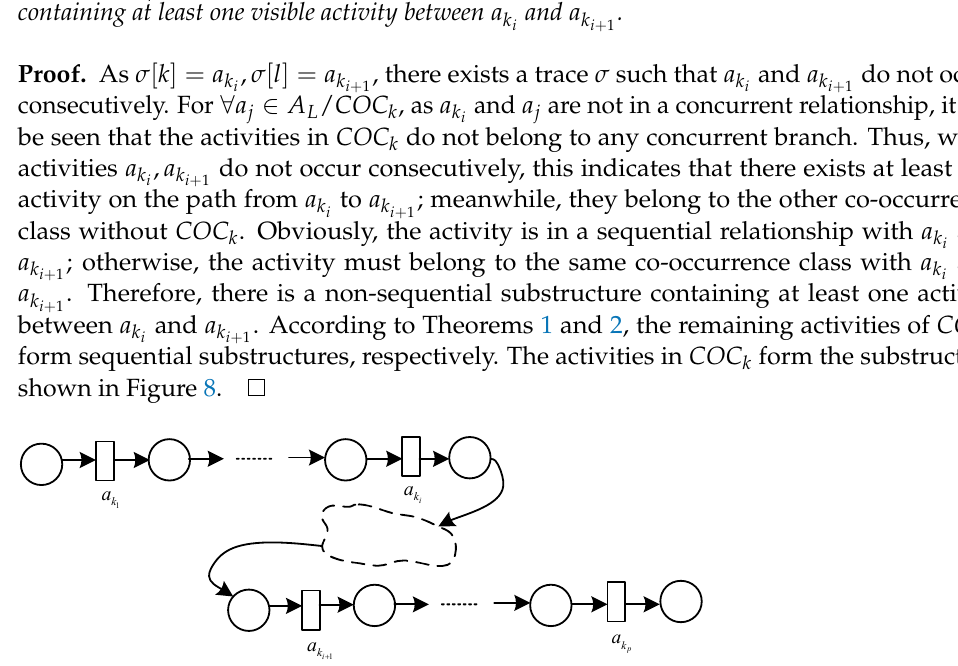
Figure 8. A substructure corresponding to the co-occurrence class with a strict order